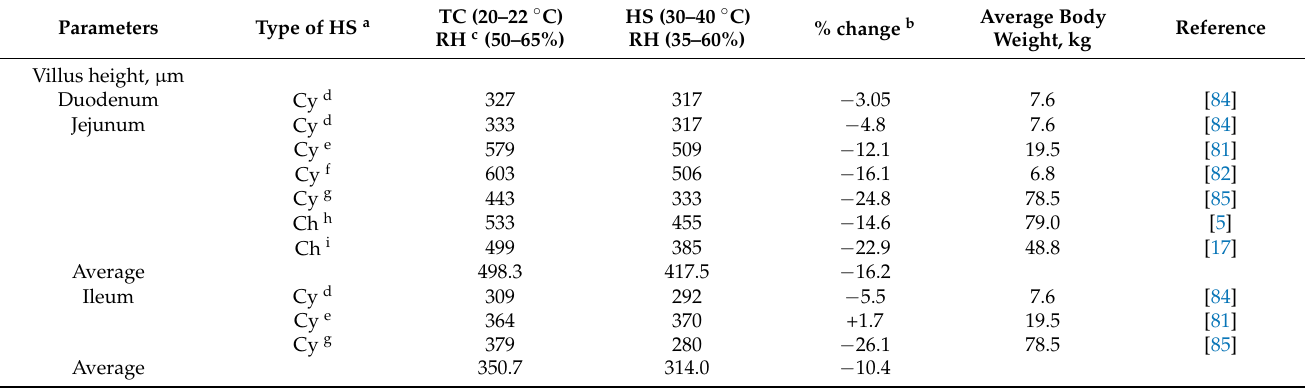
Table 1. Intestinal morphology of pigs under thermal comfort (TC) and heat stress